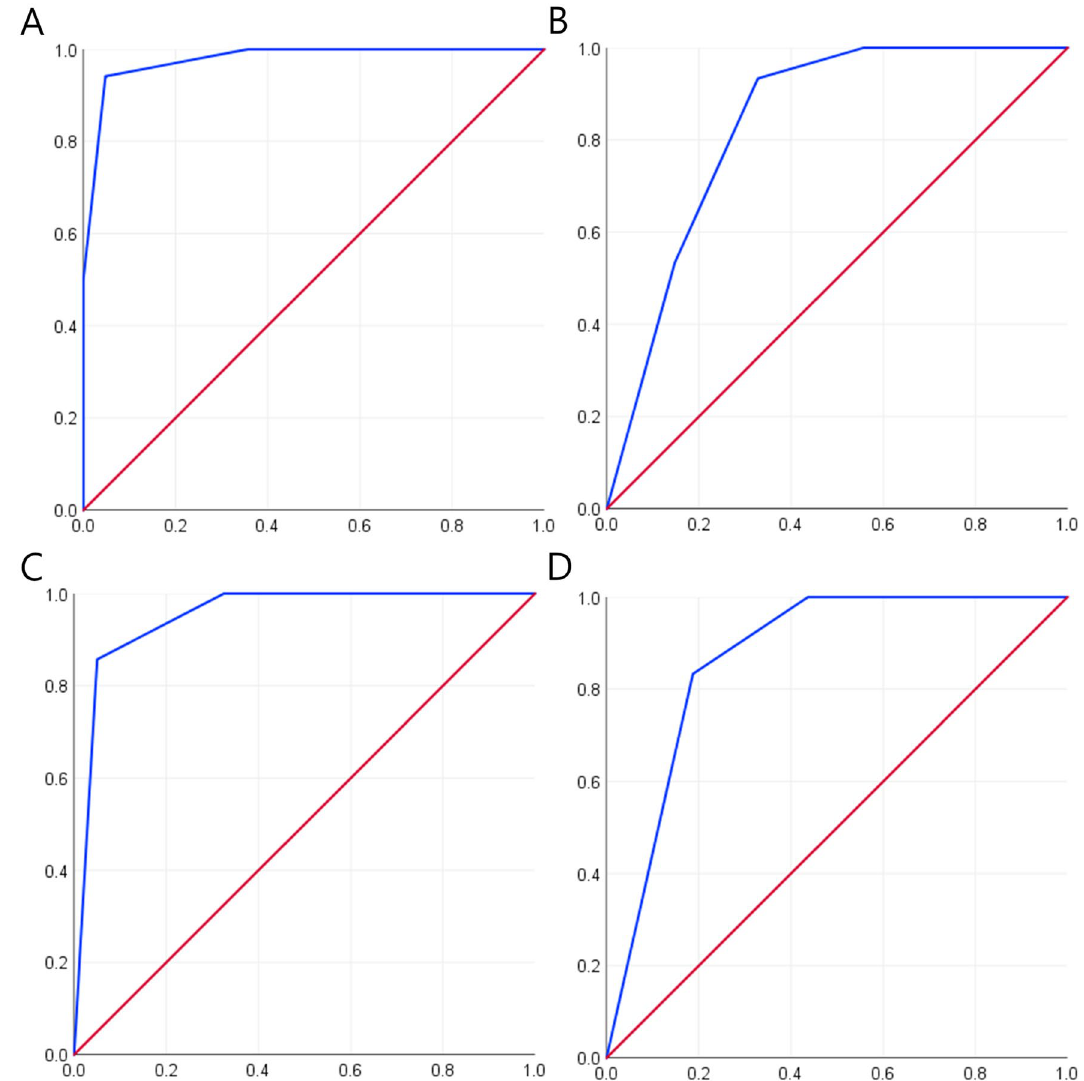
Figure 2. Receiver operating characteristic (ROC) curve analysis for a poor neurological outcome and mortality at 6-month. Receiver operating characteristic (ROC) curves for the association of the risk score with a poor neurological outcome (modified Rankin score > 2) and with mortality at 6-month in the total study population (Panels ( A ) and ( B ), respectively) and in the subgroup without baseline encephalitis feature (Panels ( C ) and ( D ), respectively). In each panel, blue lines indicate the ROC curve and red lines indicate the reference